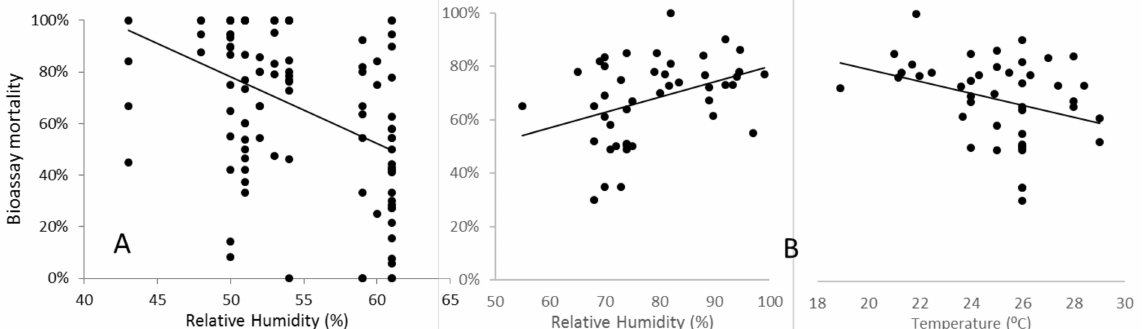
Figure 8. Effects of environmental conditions recorded in field insectaries during the insecticide exposure period on bioassay mortality ( A ) humidity on permethrin assays performed on Ugandan An. gambiae [26] and ( B ) humidity and temperature on deltamethrin assays on Sudanese An. arabiensis [22]. All regression lines were highly